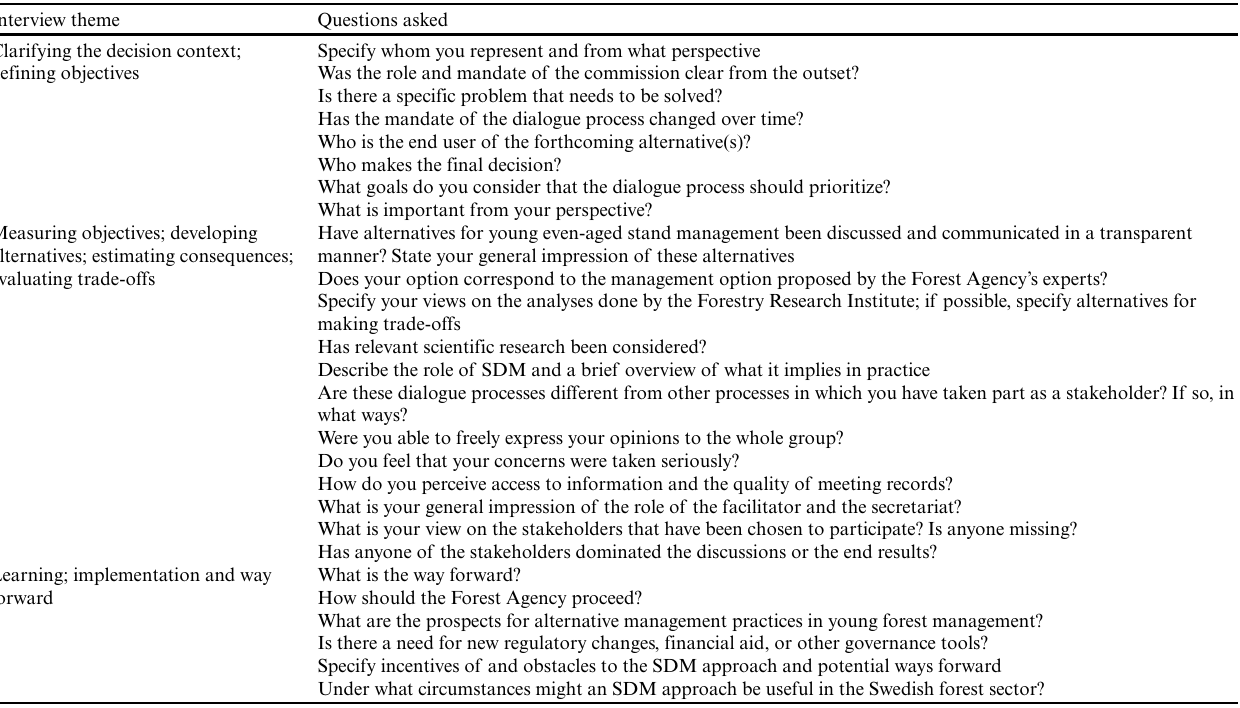
Table 2. Interview themes and questions.